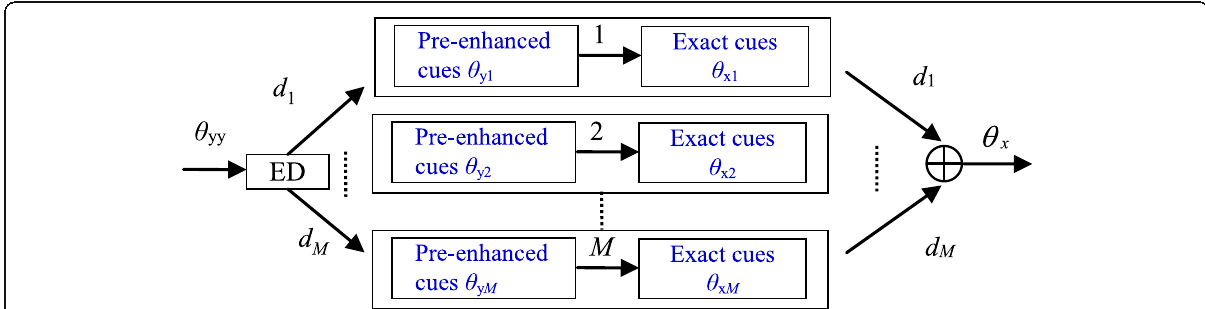
Fig. 4 Block diagram of extracting exact inter-channel cues from the